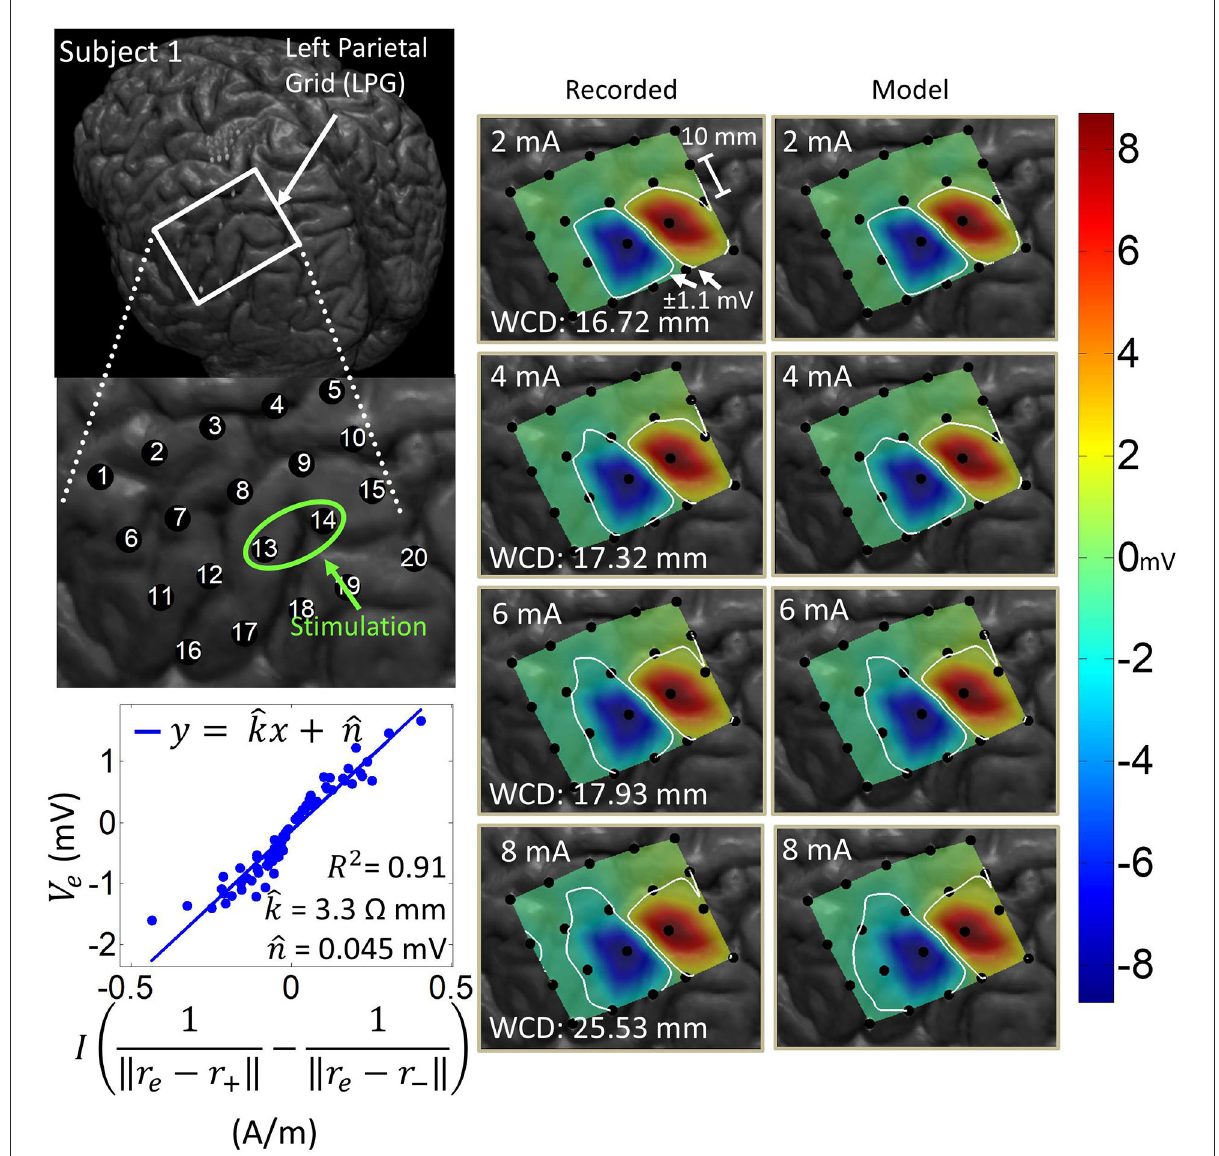
FIGURE5 Artifact spatial maps based on recorded ECoG data and model predictions for Subject 1. (Top left) Co-registration image showing the representative grid over the left parietal lobe. (Bottom left) Regression results aggregating data from stimulation channel LPG13-14 for 2–8 mA stimulation amplitudes. Artifact spatial maps were generated using values from the recorded data (middle) and the dipole model (right) . The worst-case distance (WCD) is the distance from the center of the stimulating channel to the farthest point on the ± 1.1 mV contour. Note that the electrodes comprising the stimulation channel (LPG13-14) were saturated on the hospital ECoG recording system and recorded no data. As such these were excluded from the dipole regression and their values were set to ± 8.711 mV (the saturation limit of the hospital ECoG recording system) on the artifact spatial